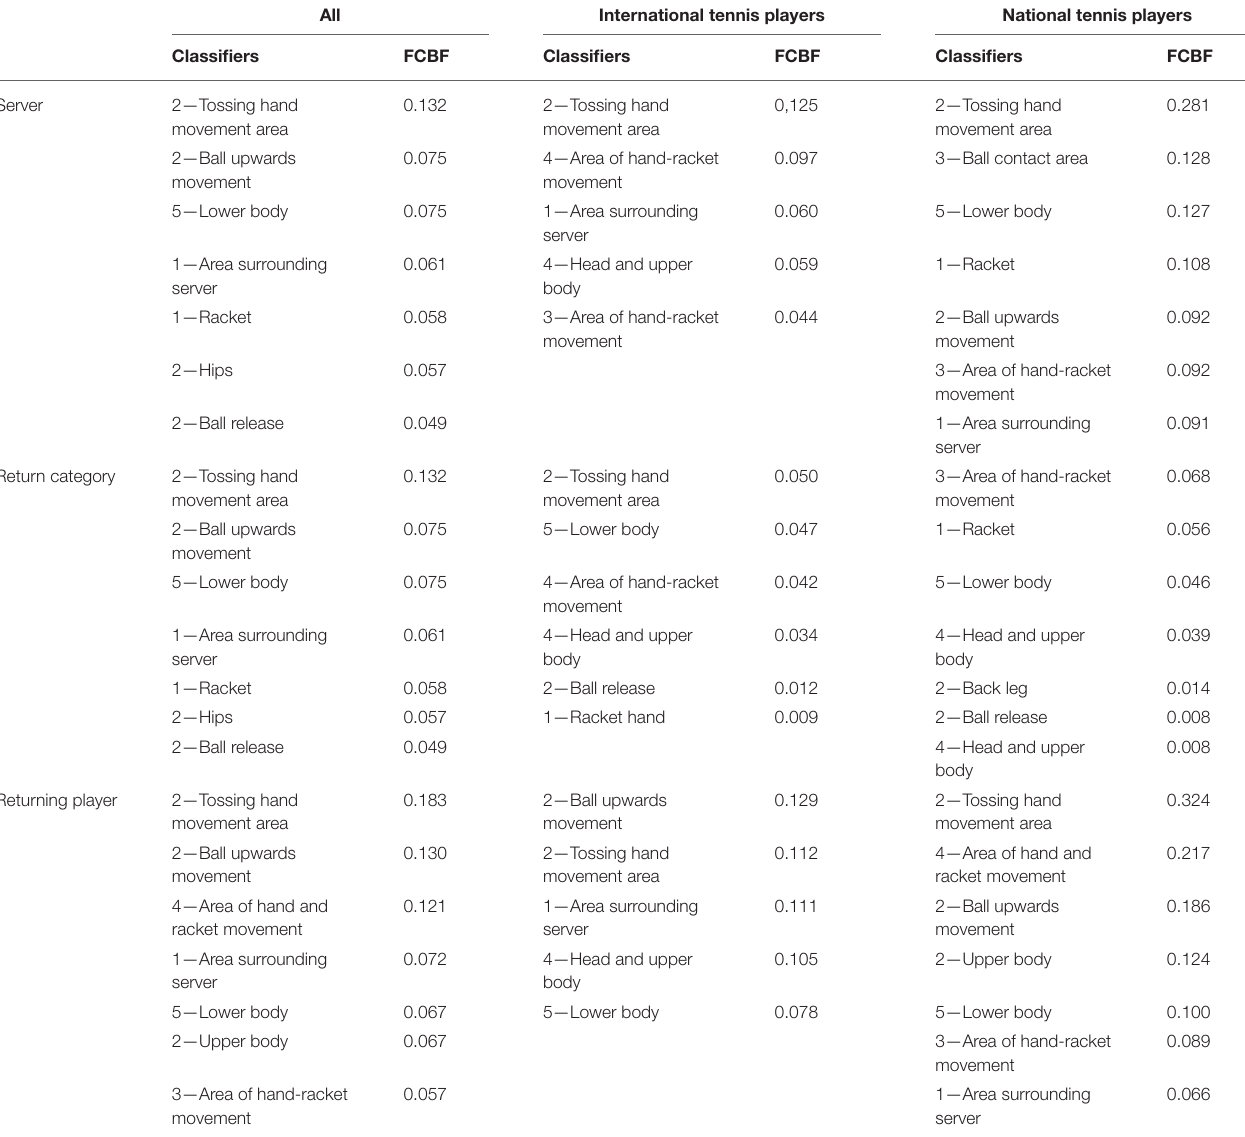
TABLE 3 | Classifiers best predicting the individual server and return performance